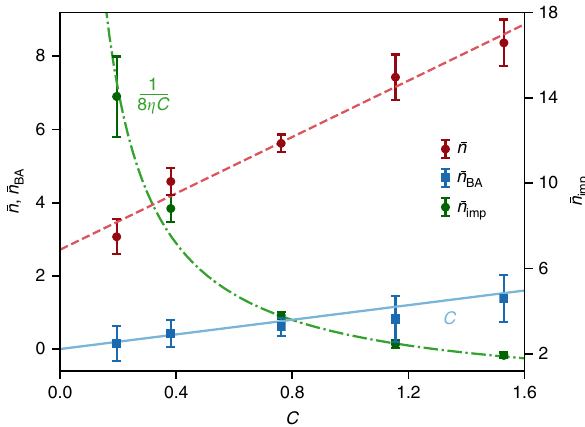
Fig. 4 Effect of probe power on quantum backaction and optical absorption heating. The measurements were carried out at 1.6 K and 3 He buffer-gas ’ 5 : 0). The occupation (cid:2) n and the pressure of 30 mbar, with n c ’ 420 ( C cool number of evaded quantum backaction phonons n vs. independently BA measured C are plotted on the left axis. For each value of C , a sweep similar to Fig. 3 was performed, consisting of 7 noise spectra with δ /2 π = {0, ±0.5, Fig. 3 Experimental observation of backaction evasion. a , b Non-BAE and ±3, ±4} MHz. Each sweep was self-calibrated using motional sideband BAE measurements, respectively, as explained in the main text (see also asymmetry applied to the four outermost spectra (non-backaction-evading, Fig. 1c, d). c Data traces, normalized to the vacuum noise level, for non-BAE see Fig. 3), taking the mean and SD of the four calibrations to infer data and (cyan) and BAE measurements (purple) are shown with Lorentzian fi ts. The ¼ C . The dashed red error bars, respectively. The solid blue line plots n BA non-BAE sidebands exhibit motional asymmetry, used to self-calibrate the line is a linear fi t to (cid:2) n with slope β C where β = 3.85. The right axis shows measurement in units of mechanical quanta. The sum of the non-BAE ¼ 1 = 8 η C yielding η = 0.04 the imprecision noise with a fi t n imp sidebands, indicated in dashed cyan, is larger than in the BAE case (purple) by 0.7 mechanical quanta. The right inset is a zoom of the indicated region. The left inset shows the inferred occupation (cid:2) n as a function of the detuning δ , with an analytic curve based on Eq. (1) with no free parameters. In this ¼ 3 : measurement, n P = 290, n c = 320, and C cool